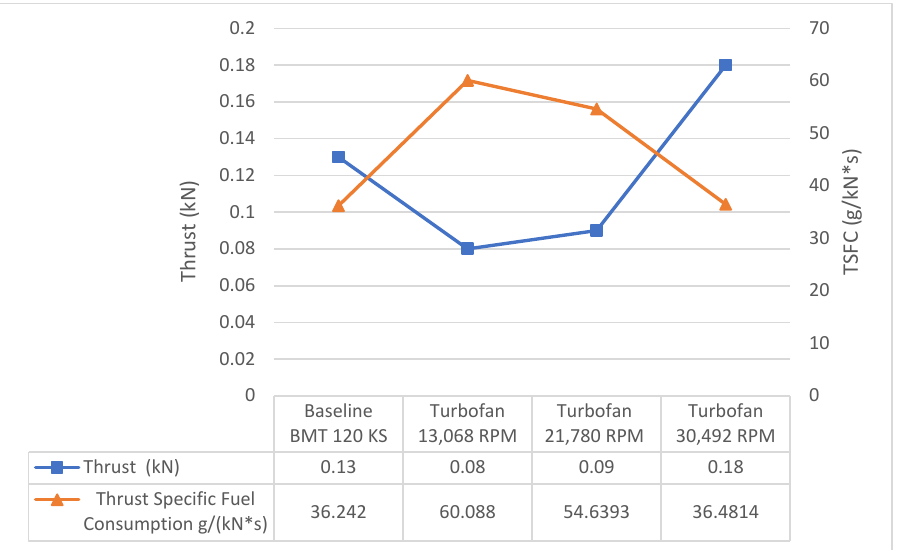
Figure 10. Comparison of the baseline turbojet simulated results to the converted turbofan at variable gear ratios.